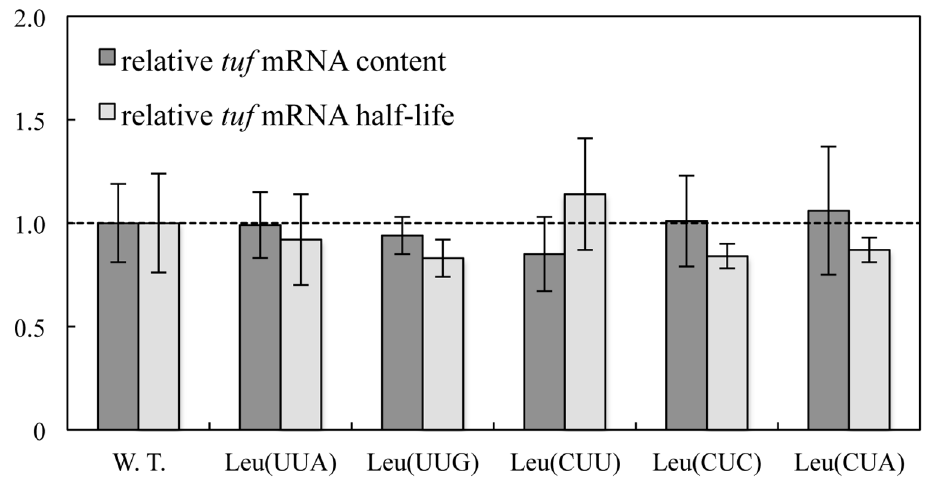
Fig 4. Analysis of tuf mRNA. Relative tuf mRNA content (dark grey) and relative tuf mRNA half-life (light grey) for wild-type tufA and synonymous tuf alleles with all leucine codons changed to UUA, UUG, CUU, CUC or CUA, respectively. Results are shown as means ± standard